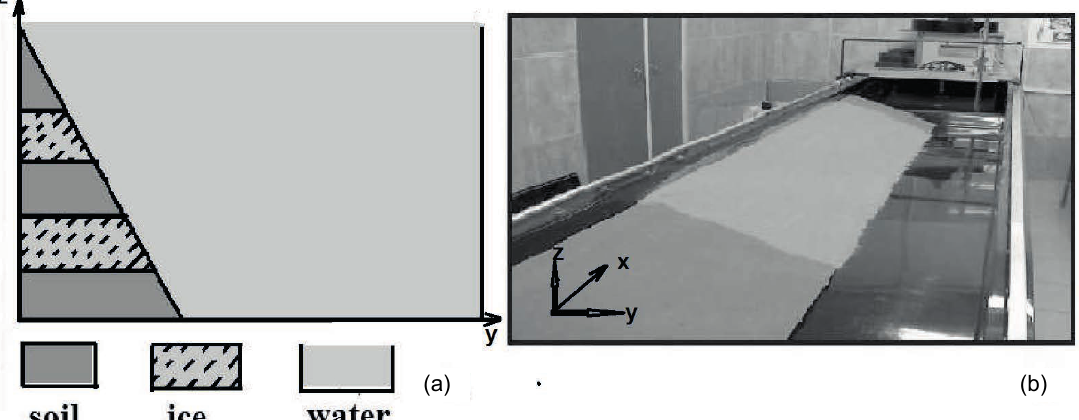
Fig. 1 A cross section (plane y-z) corresponding to the laboratory experiments (a) and the photo of the tray